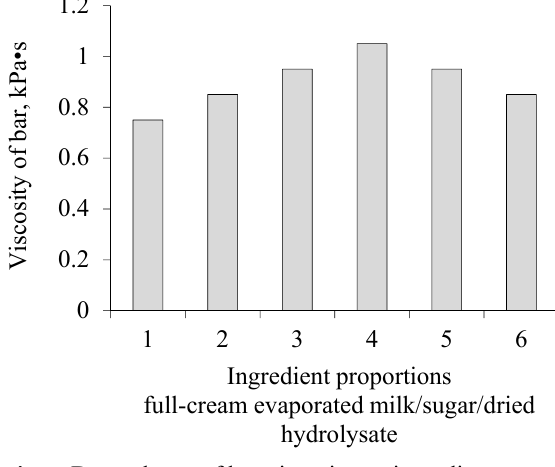
Fig. 4. Dependence of bar viscosity on ingredient proportion at 40°C (1 – 100 : 43 : 2; 2 – 105 : 38 : 2; 3 – 110 : 33 : 2; 4 – 110 : 32 : 3; 5 – 105 : 37 : 3; 6 – 100 : 42 : 3).